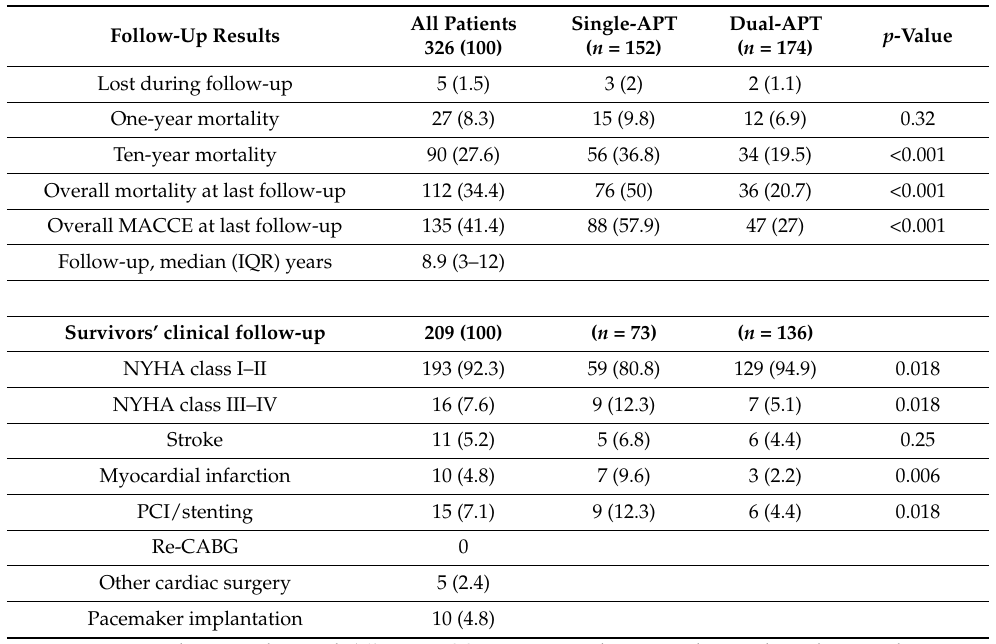
Table 4. Long-term clinical